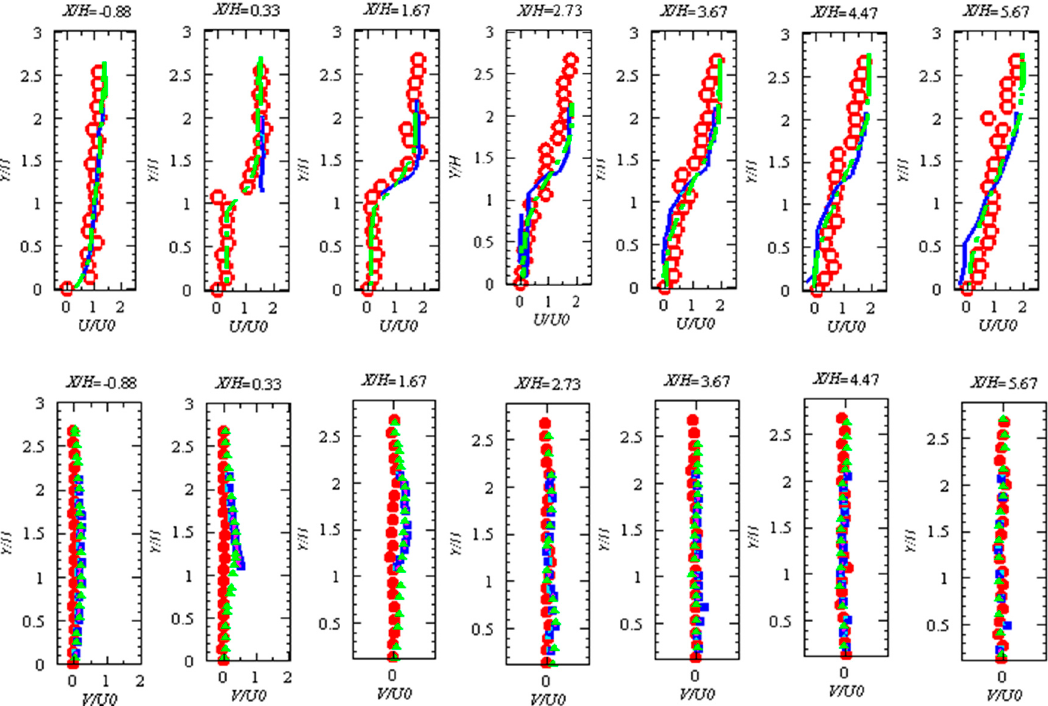
Figure 7. Comparison of longitudinal and vertical velocity for porosity 0.349 Legend: Red open circle: numerical simulation of longitudinal velocity of SPH; Green dash dot: numerical simulation of longitudinal velocity presented by Chan et al. [7]; Blue solid line: experimental longitudinal velocity values from Chan et al. [7]; Red solid circle: numerical simulation of vertical velocity of SPH; Green solid triangle: numerical simulation of vertical velocity of Chan et al. [7]; Blue solid square: experimental vertical velocity values from Chan et al. [7]. H: water depth (m); U: longitudinal flow rate ( m / s ), V: vertical flow rate ( m / s ), U0: Inlet boundary velocity ( m / s ). X is the distance between the particle and the left boundary of the pore structure, H is the height of the pore structure, and X / H is a dimensionless treatment of the X axis. The pore structure is placed at the origin of this system.